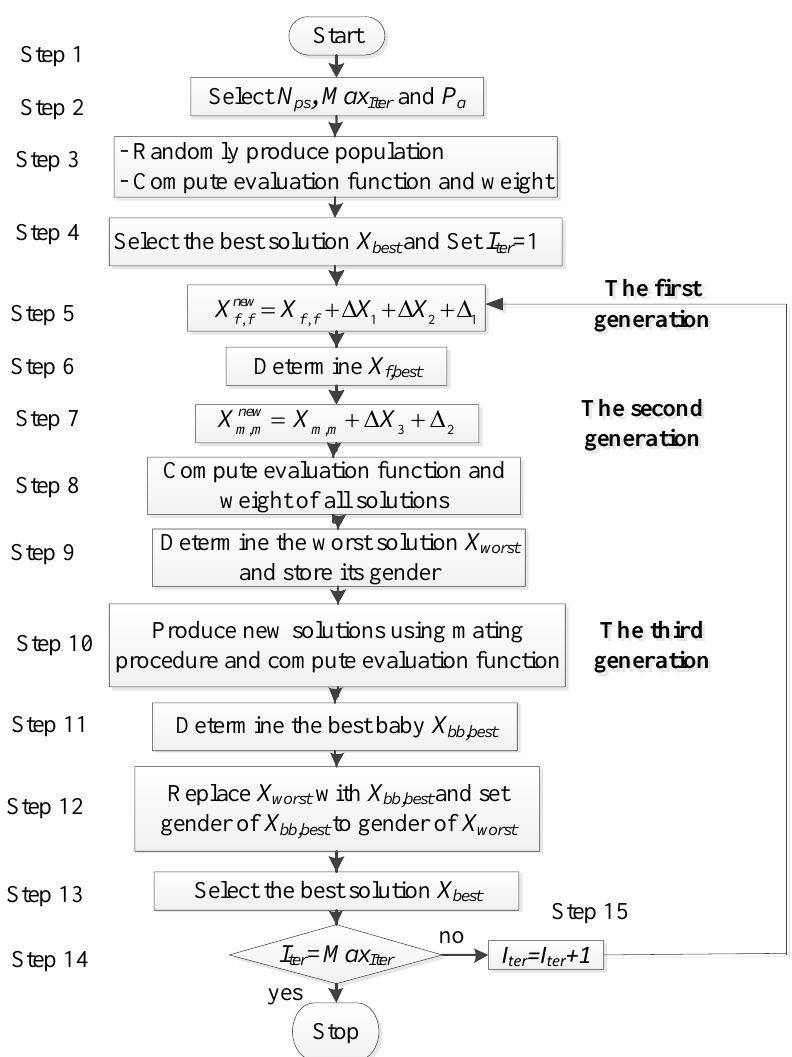
Figure 2. The flowchart of solving a typical optimization problem by using ISSO.